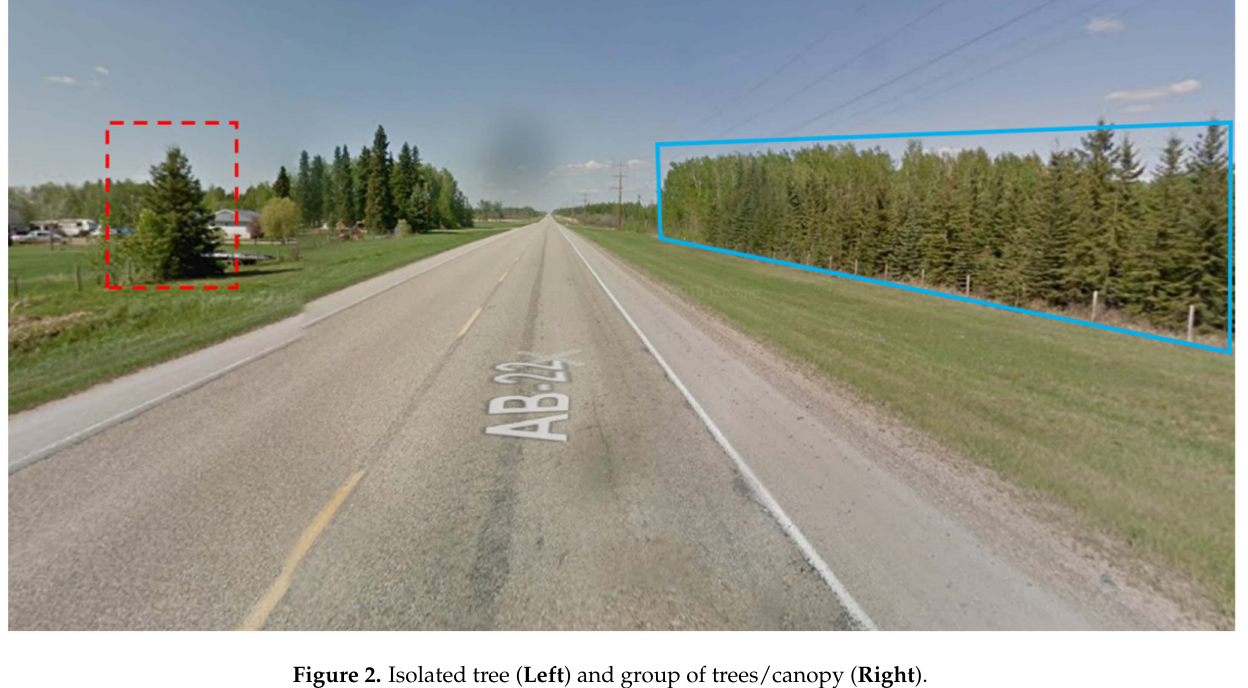
Figure 2. Isolated tree ( Left ) and group of trees/canopy ( Right ).